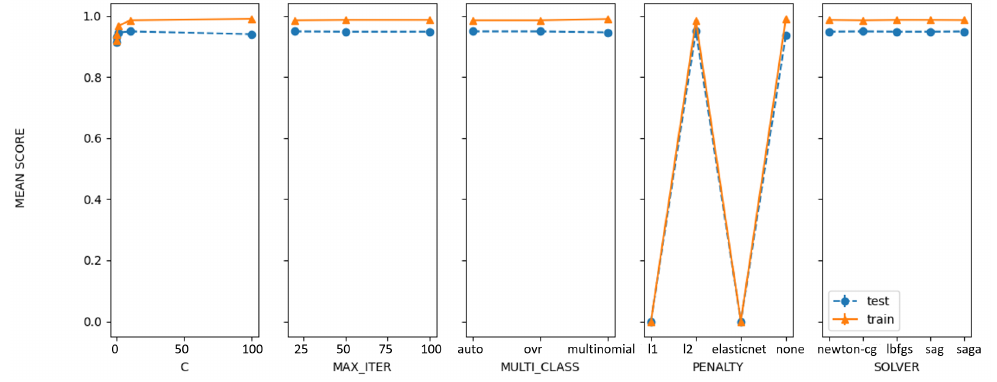
Figure 18. /hlScore per parameter for Logistic Regression (LG). Table 7. Hyperparameter tuning for Naive